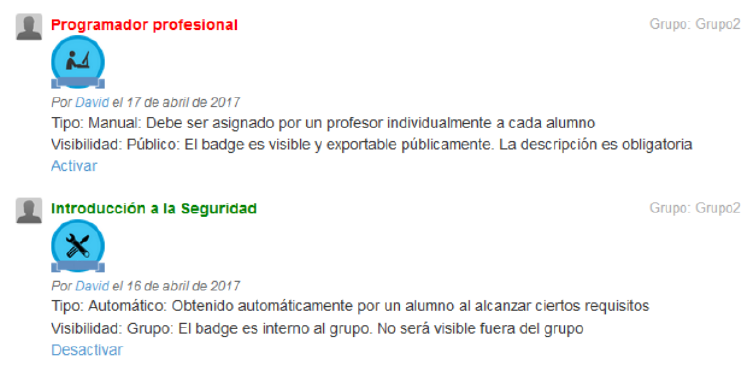
Figure 5. List of badges of a